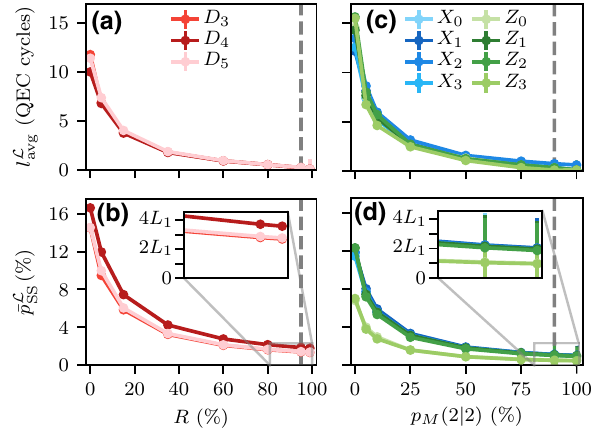
FIG. 4. Average leakage lifetime l L [(a),(c)] and leakage avg steady state ¯ p L [(b),(d)] as a function of the leakage-reduction SS rate R for data qubits [(a),(b)] and as a function of the readout probability p M ( 2 | 2 ) for ancilla qubits [(c),(d)]. Here we fix the CZ leakage rate to L 1 = 0.5%. The insets in (b) and (d) show tends to approximately N flux L 1 ( N flux = 4 for D 4 , 3 for that ¯ p L SS D 3 , D 5 , 1 for Z 0 , Z 3 , and 2 for the remaining ancilla qubits). The vertical dashed lines correspond to the values used in Sec. II D. These results are extracted from 2 × 10 4 runs of 20 QEC cycles each per choice of parameters. Error bars are estimated using bootstrapping and are mostly smaller than the symbol